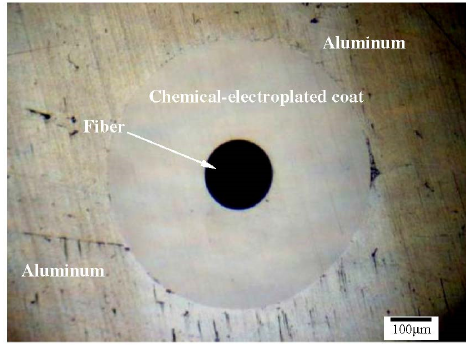
Figure 20. The aluminum/chemical-electro plated fiber/aluminum [93].